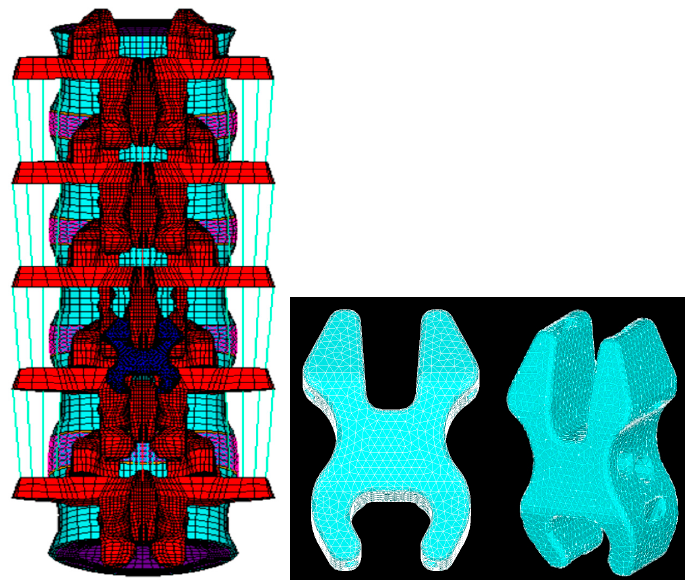
Figure 3. FE model of the lumbar spine with the